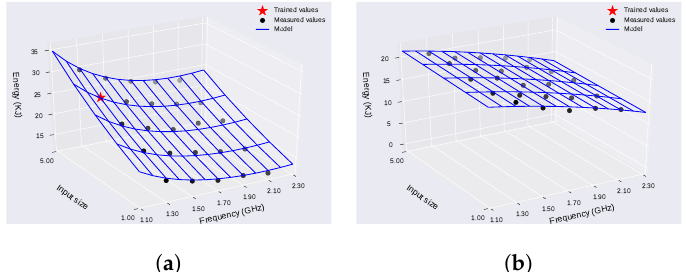
Figure 7. Example fit for a specific input size: Blackscholes ( a ) and Canneal ( b ). “measured values” are the sensor data and “minimum energy” is the minimum energy model prediction.